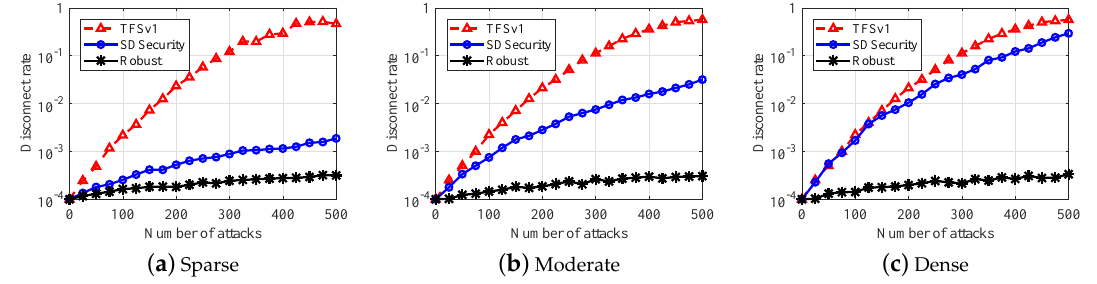
Figure 9. Comparison under IP spoofing. ( a ) sparse; ( b ) moderate; ( c )